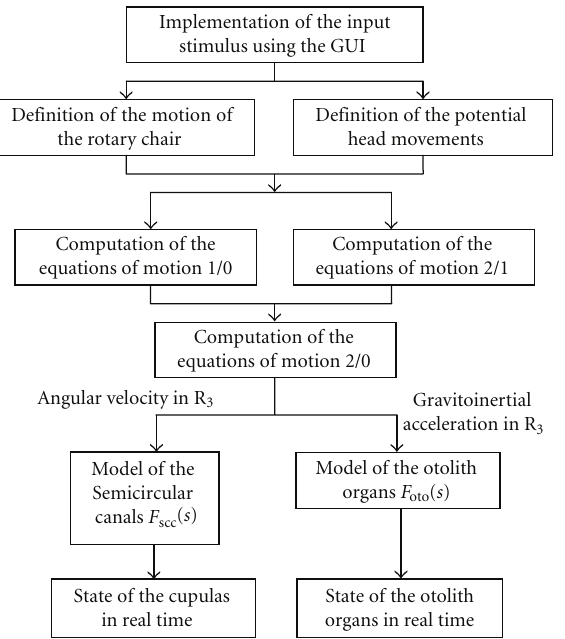
Figure 5: Schematic block diagram of the simulink model. The computation of the model is divided in several steps. First, the user implements the motions. Then, as soon as the simulation is run, (1) equations of motion are solved; (2) angular velocity and gravitoinertial acceleration are applied to the sensors models; (3) the state of each sensor is determined in real time.